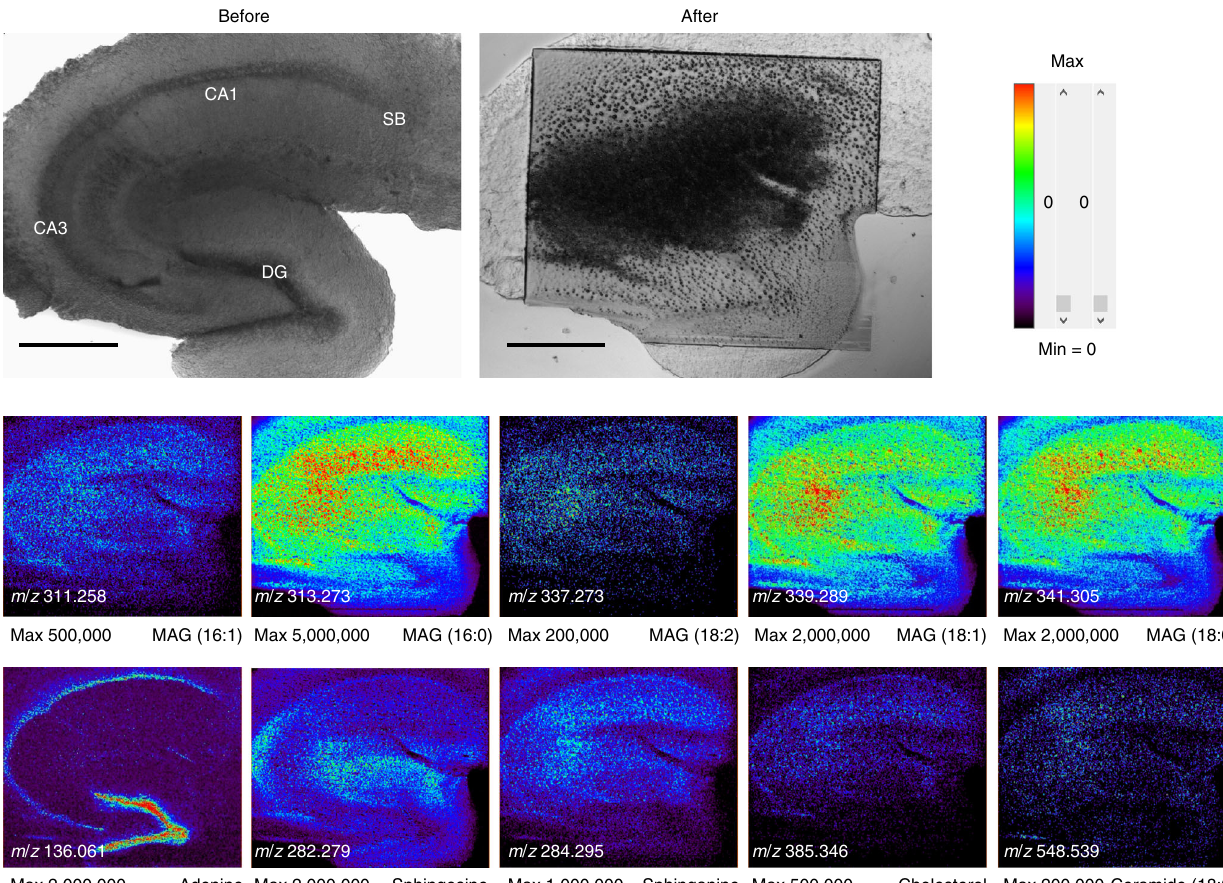
Fig. 3 Optical images and mass spectrometric (MS) images of a mouse hippocampal tissue slice. The upper two optical images indicate differential interference contrast (DIC) images of a mouse hippocampal tissue slice. A clear distinction among sub-regions, such as cornu ammonis 1 (CA1), cornu ammonis 3 (CA3), dentate gyrus (DG), and subiculum (SB), could be observed. Before: before the MS analysis (the sample preparation was done). After: after MS analysis. Mass spectra data were achieved from 129,900 different points. Therefore, we could reconstruct MS data with spatial information and fi nally completed MS imaging. (MAG stands for monoacylglycerol in ion images.) Ion images were obtained from live hippocampal tissues of an adult mouse. Ion images were generated with 433 × 300 pixels covering an area of 1800 × 1500 µ m, and the corresponding x -axial and y -axial pixel sizes were 4.2 and 5 µ m, respectively. These ion images had x -axial and y -axial lateral resolutions of 5.1 and 5 µ m, respectively (Fig. 5). Scale bars, 500 μ